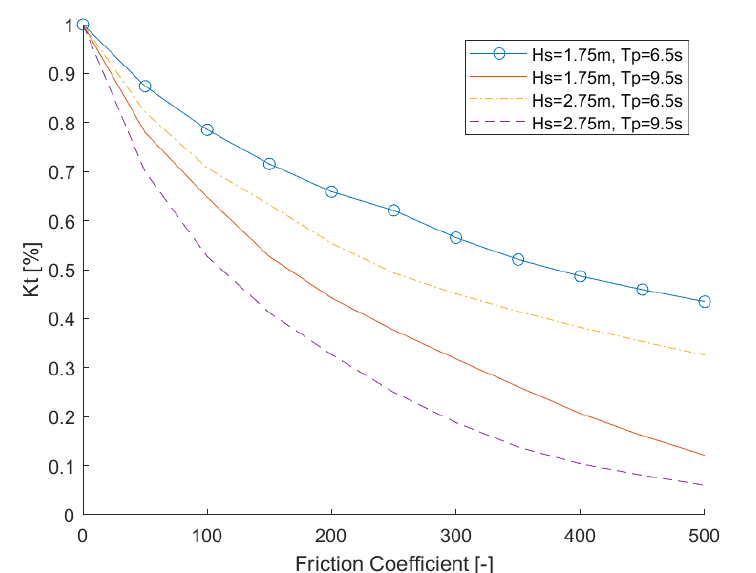
Figure 9. Friction coefficient effect on the transmission coefficient across different wave conditions. Four wave conditions and various friction coefficients were tested. The corresponding transmission coefficient was obtained at the location of the WEC for each f w